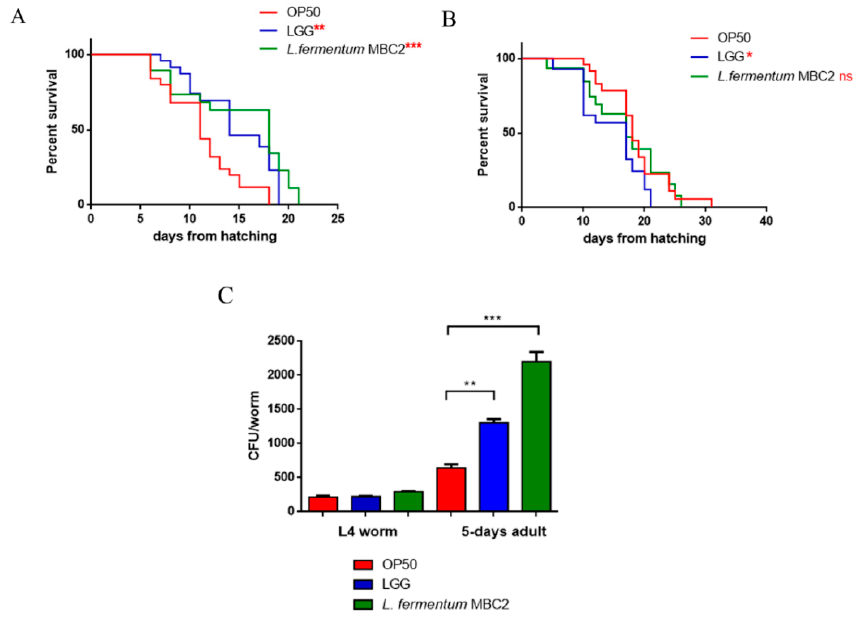
Figure 1. Effect of L. fermentum MBC2 on nematode lifespan and colonization capacity. ( A ) Kaplan–Meier survival plot of N2 worms fed L. fermentum MBC2. Lifespans of OP50- and LGG-fed animals are reported as controls; n = 60 for each data point of single experiments. ( B ) Effect of heat-killed strains on C. elegans viability. ( C ) Bacterial colony forming units (CFU) recovered from nematodes were obtained by plating whole lysates of L4 and 5-day-old adults fed L. fermentum MBC2, LGG or OP50. Bars represent the mean of three independent experiments. Asterisks indicate significant differences (* p < 0.05, ** p < 0.01, *** p < 0.001), ns: not significant.